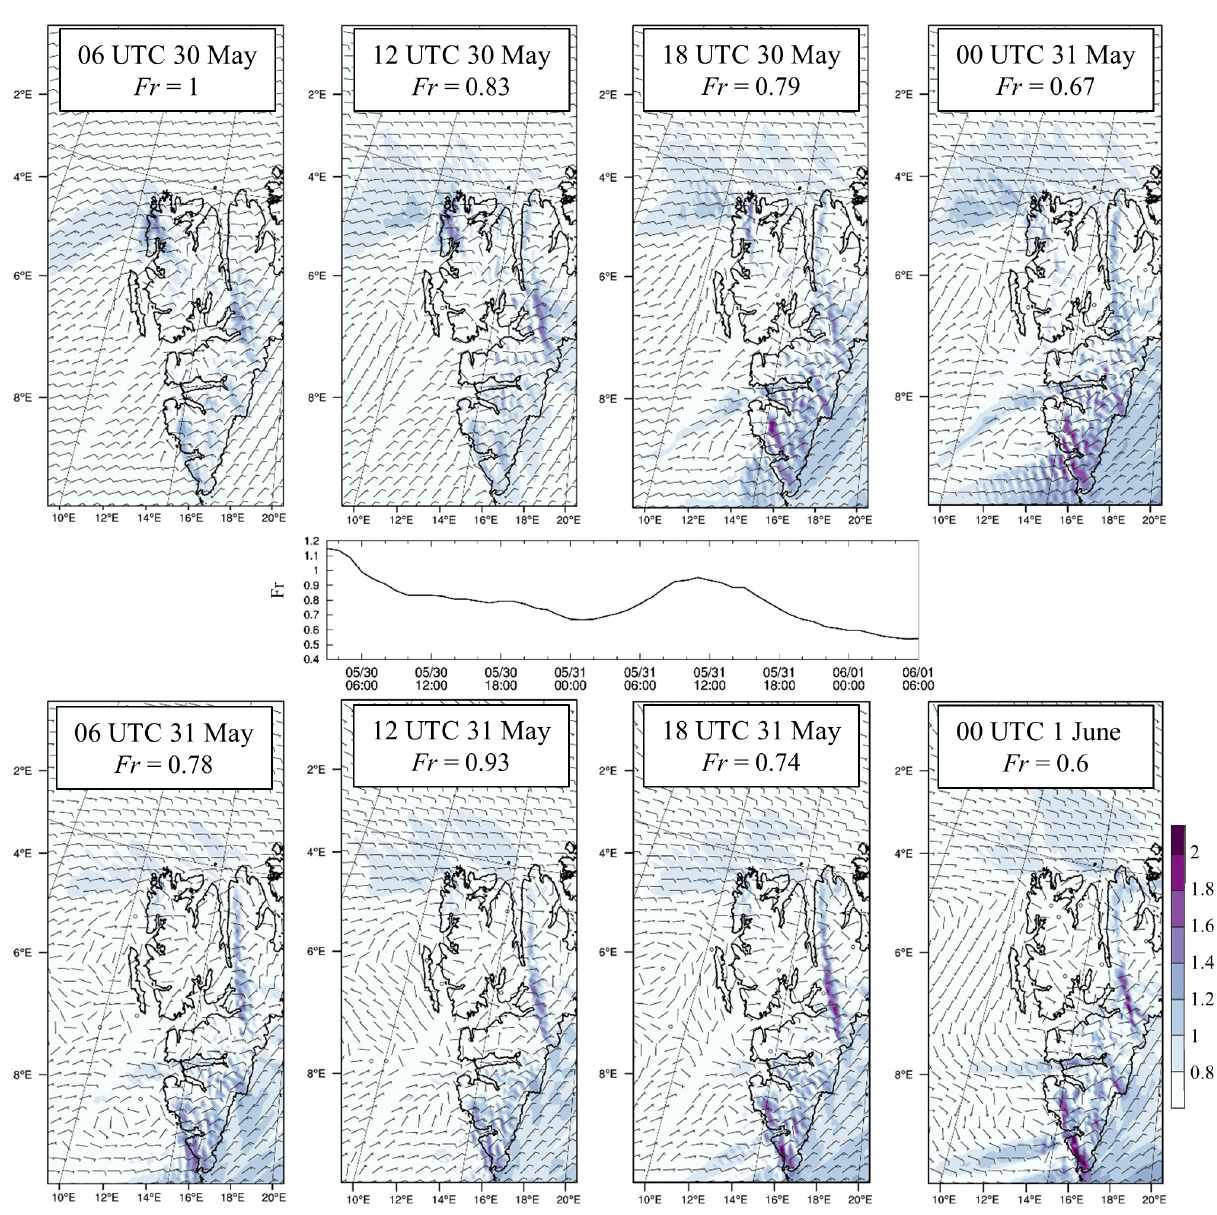
Figure 10. Dynamics of orographic flows during the observed foehn episode: wind speed (at 10ma.g.l.) normalized to windward wind speed (averaged in the lowest 1.7km layer at 80 ◦ N, 35 ◦ E (near Kvitøya)) (color) and wind direction (barbs) at 10ma.g.l. and Fr number in the incoming flow (center panel) according to WRF